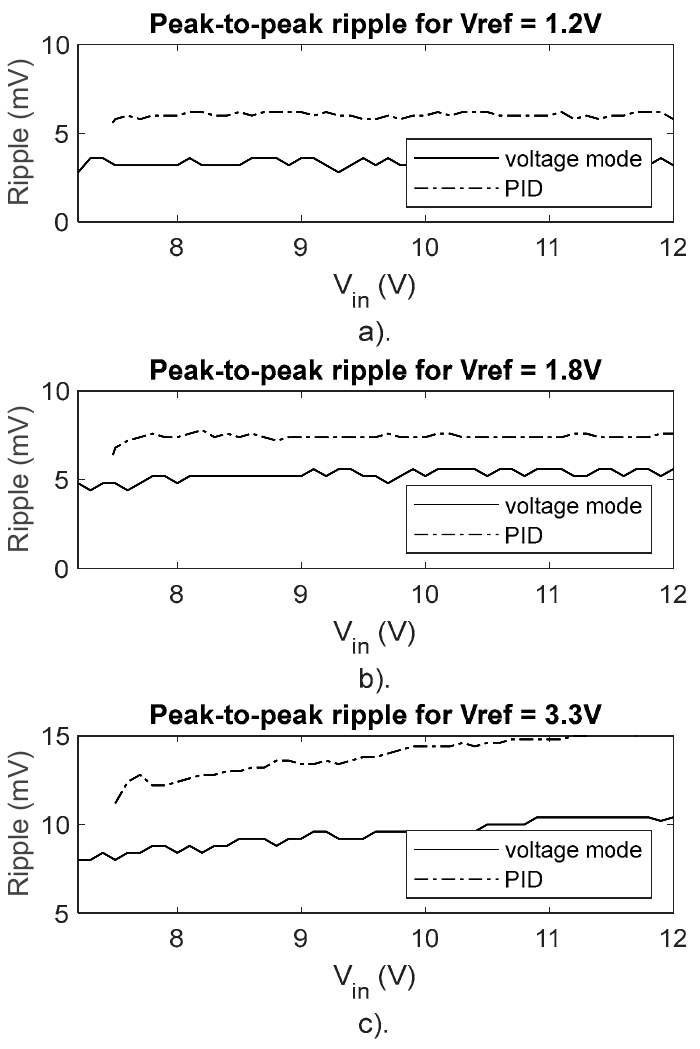
Figure 11. Voltage ripple for: ( a ) V ref = 1.2 V, ( b ) V ref = 1.8 V, ( c ) V ref = 3.3 V.